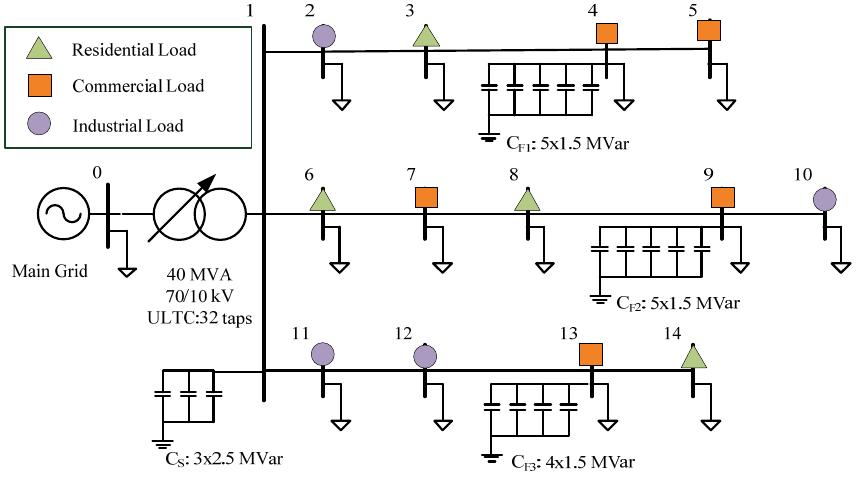
Figure 6. Test case of standard 14 ‐ node system.